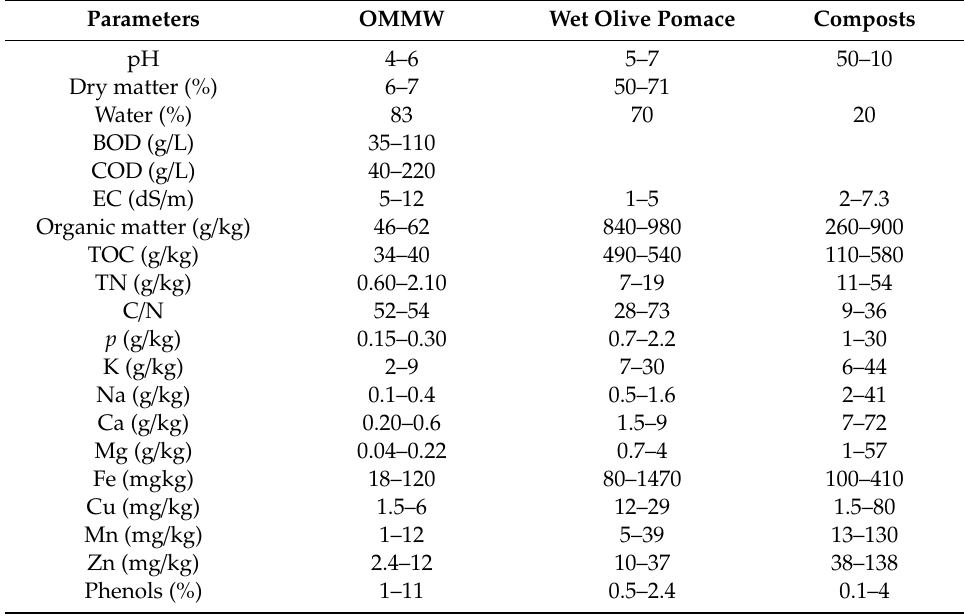
Table 2. Chemical Composition of oil mill wastewater (OMWW), Pomace and Composts